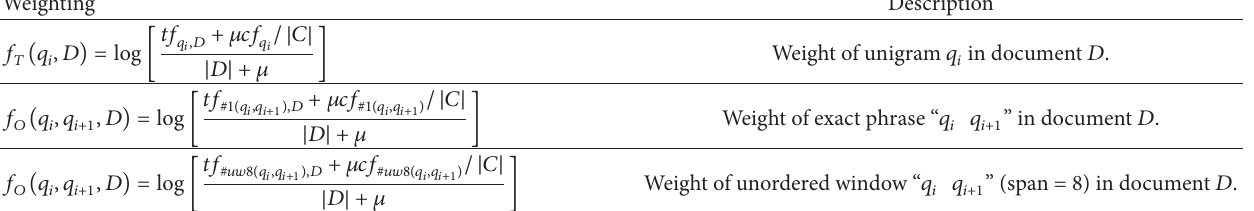
Table 1: Language modeling-based unigram and term weighting functions. Here, 𝑡𝑓 𝑒,𝐷 is the number of times term 𝑒 matches in document 𝑒 matches in the entire collection, |𝐷| is the length of document 𝐷 , and |𝐶| is the size of the collection. 𝐷 , 𝑐𝑓 𝑒,𝐷 is the number of times term Finaly, 𝜇 is a weighting function hyperparameter that is set to 2500. Weighting Description